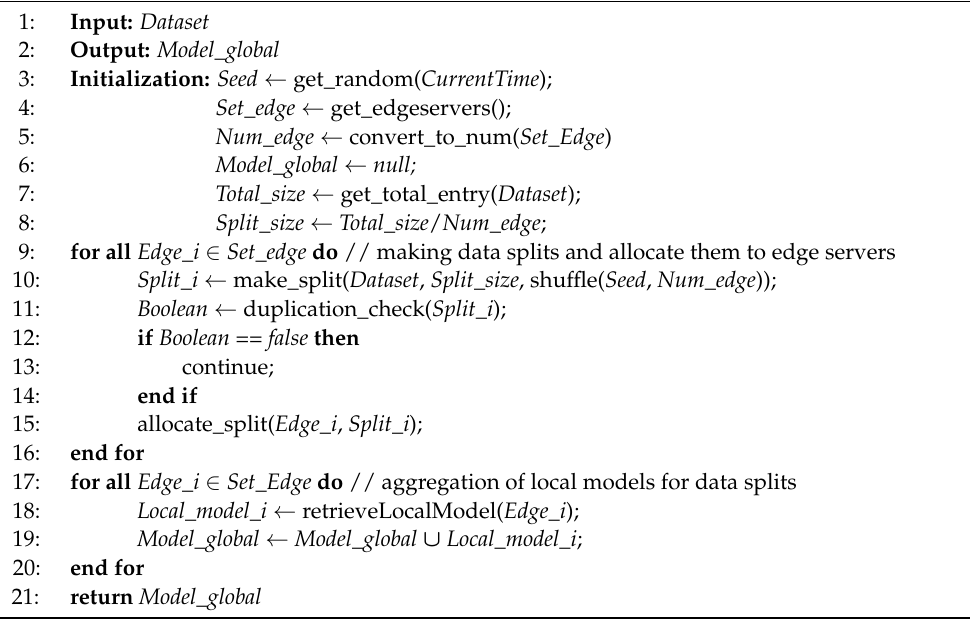
Algorithm 1. Partitioning Algorithm for Parameter